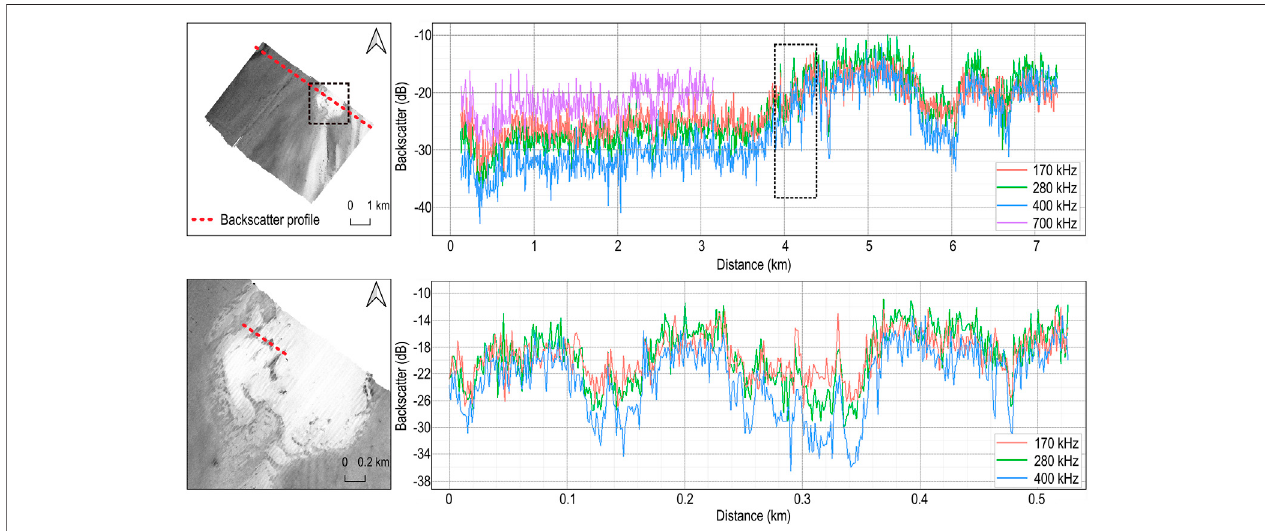
FIGURE 7 | Top: comparison of differences in multispectral backscatter intensities along the transect shown in the mosaic (top left). Bottom: comparison of differences in multispectral backscatter intensities along the transect shown in the mosaic inset (bottom left).